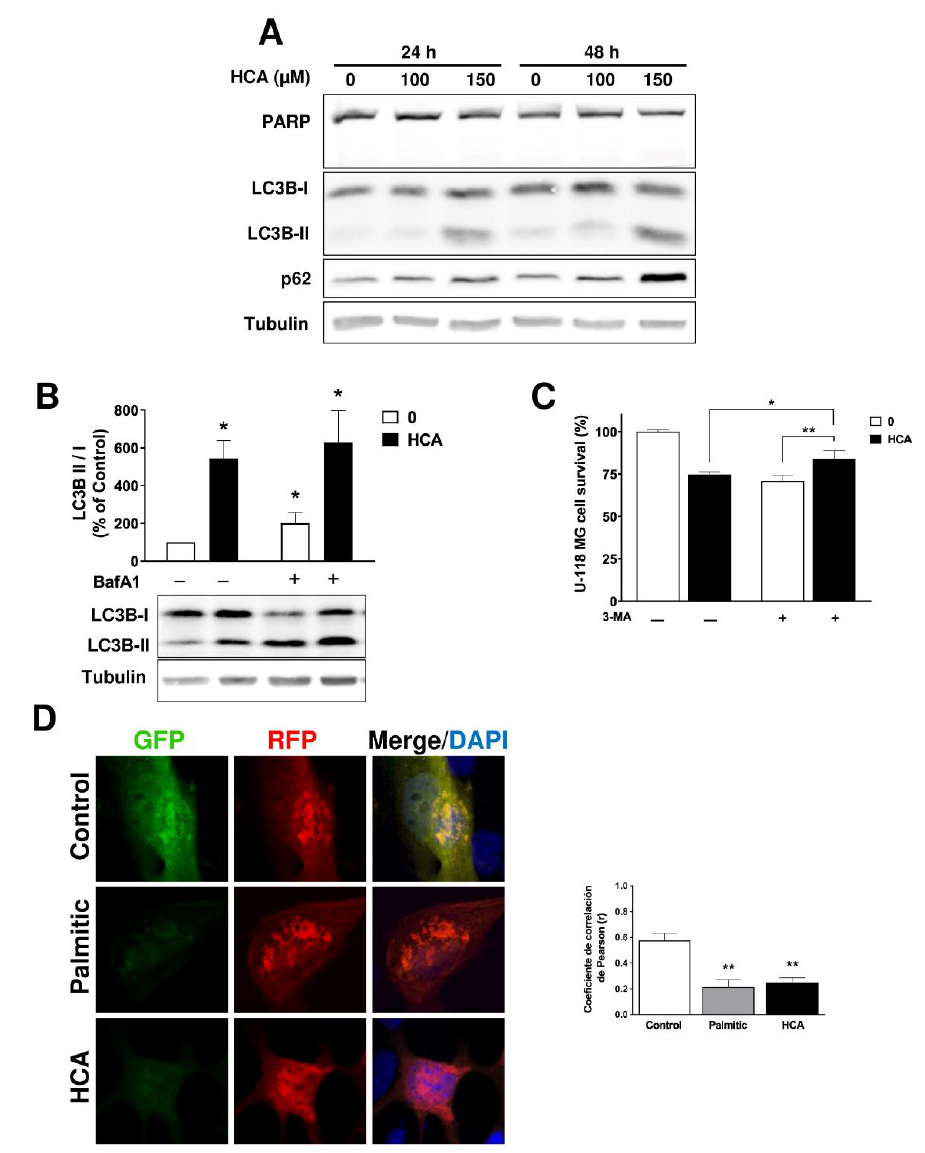
Figure 3. HCA induces autophagy in U-118 MG GBM cells. ( A ) Representative immunoblots of the effect of HCA (100 or 150 µ M for 24 or 48 h) on the PARP, LC3B, and p62 proteins in U-118 MG cells, using tubulin as a loading control. ( B ) Effect of bafilomycin A1 (BafA1) on the LC3B-II levels in HCA- treated cells. ( C ) Effect of 3-Methyladenine (3-MA) on the survival of HCA-treated U-118 MG cells. The cells were pretreated with BafA1 (10 nM) or 3-MA for 1.5 h before exposure to HCA (150 µ M) for 48 h (bars correspond to the mean ± SEM values of 3 independent experiments). ( D ) Monitoring autophagy flux. The cells were transfected with the ptfLC3 plasmid expressing LC3 tagged with GFP and RFP, and then treated with palmitic acid (150 µ M, positive control of autophagy) or HCA (150 µ M) for 48 h. Nuclei were labeled with DAPI. Representative micrographs (single confocal planes) are shown: scale bar, 5 µ m (left). Co-localization analysis of autophagosomes (green) and autolysosomes (red) using a Pearson correlation coefficient (r: bars correspond to the mean ± SEM values of 6 cells, right). Student’s t-test: ** p < 0.01, * p < 0.05 with respect to the control. HCA: 2-hydroxycervonic acid; BafA1: bafilomycin A1; 3-MA: 3-Methyladenine; GFP: Green Fluorescent Protein; RFP: Red Fluorescent Protein; LC3B: a.k.a. ATG8F, Microtubule Associated Protein 1 Light Chain 3 Beta; p62: a.k.a. SQSTM1, Sequestosome 1; PARP: Poly(ADP-Ribose) Polymerase; +: presence of the drug indicated in the figure; –: absence of the drug indicated in the